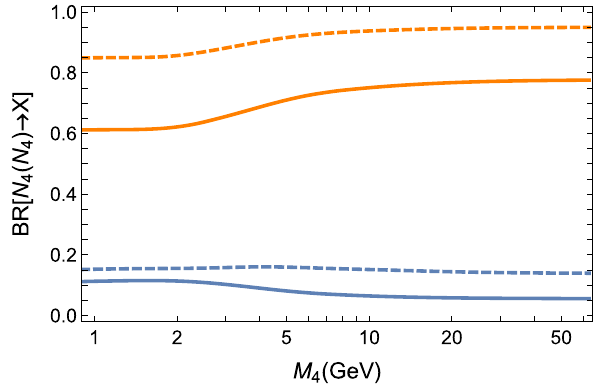
Fig. 3 Solid lines indicate the branching ratios of heavy neutrino into final states contributing to displaced dileptons (blue) and displaced jets (red). Dashed lines refer to the extended model, and show the proba- bility for the produced heavy neutrino pair to decay into the latter final